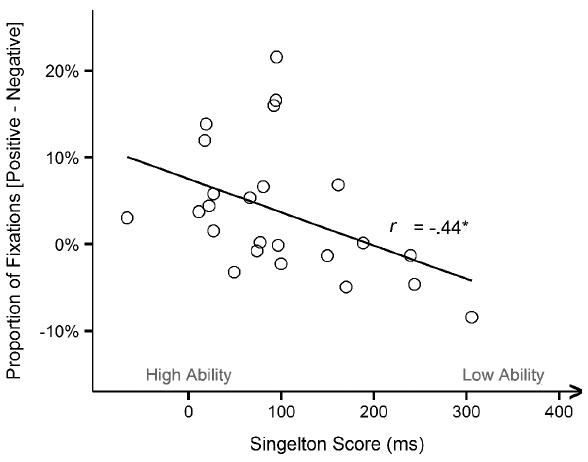
Figure 6. Correlation between the positivity effect and the singleton score. Illustrated for the number of fixations, but similar results were obtained for the fixation duration. * p , .05.